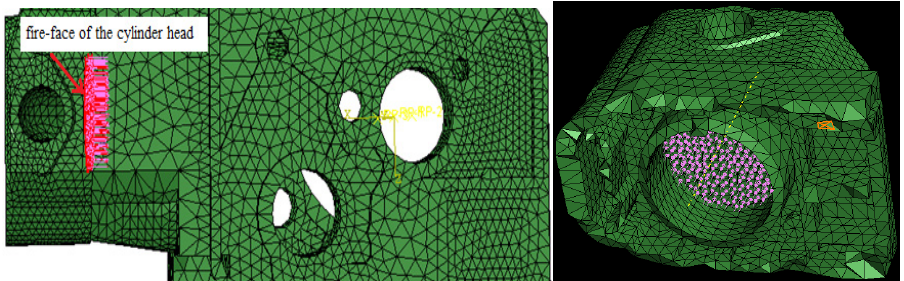
Figure 4. Application of combustion pressure in the FEA model.